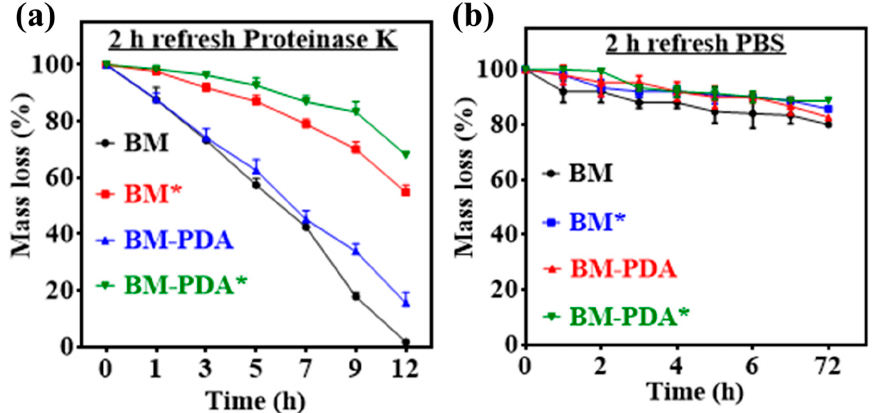
Figure 7. A degradation profile of the pristine and mineralized scaffolds in ( a ) Proteinase K solution and ( b ) PBS.